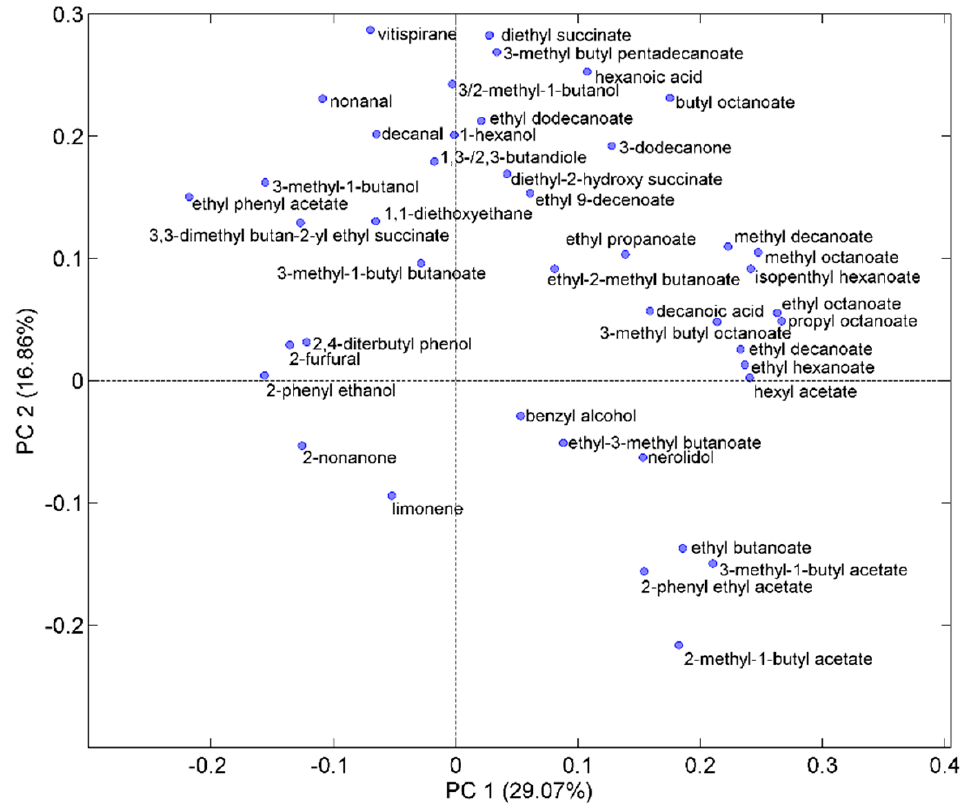
Figure 9. Projection of the variable loadings onto the plane of the first two principal components (PC1 and PC2) extracted from the volatile profiles of PEC and TRE wines collected with the DVB/CAR/PDMS fiber.